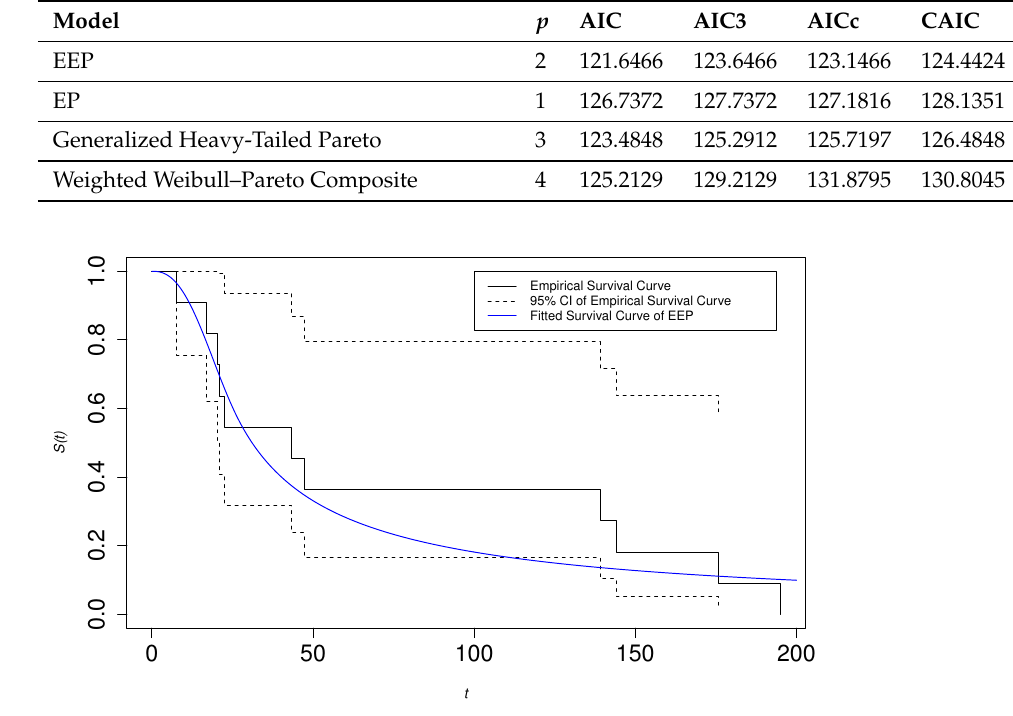
Figure 12. Fitted EEP survival curve for time to electric breakdown data